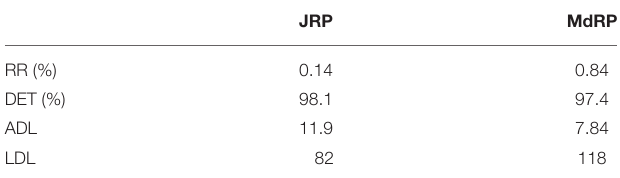
TABLE 3 | Pairwise Pearson correlation coefficients between the RQA measures shown in Figure 5 and the coupling constant ǫ 1 . RR DET